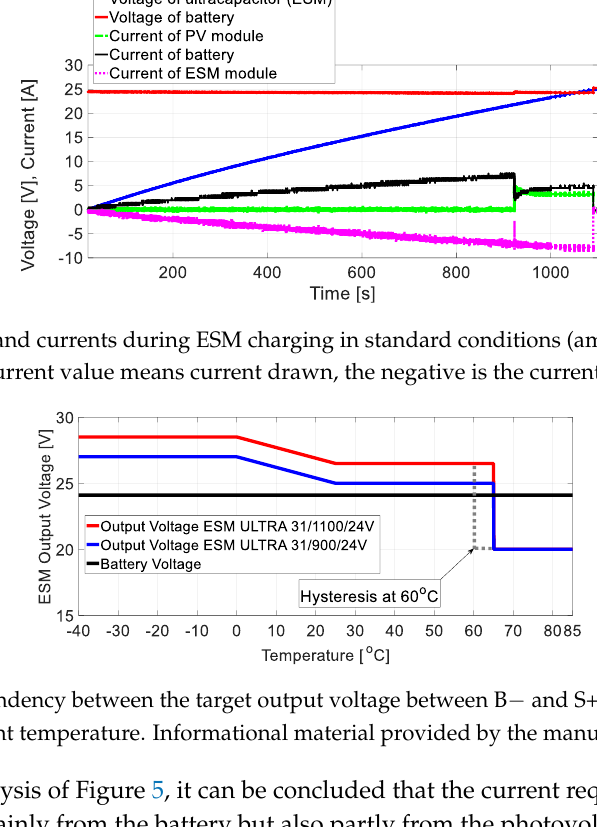
Figure 7. Voltages and currents during load: ( a ) fully charged ESM module; ( b ) partially discharged ESM, in standard conditions (ambient temperature 293 K). 5. Conclusions The experiments have shown that the ultracapacitor start-up module ESM ULTRA 31/900/24V can be extensively loaded with high current values for several-second intervals, similar to conditions during start-up cranking of high-displacement internal combustion engines. The extensive load can be applied almost to complete discharge of the ESM module (practically to the voltage of 0 V). High voltage changes help to estimate the state of charge of the ultracapacitor module and prevent the risk of a sudden loss of power of the starter motor. The voltage drop of the ESM module below a certain level can be used as a trigger signal to initialize the combustion engine start-up and start of battery charging. The proposed addition of a photovoltaic panel reduces the load on the battery during ESM charging, but most importantly, it prevents the system from the self-discharge during long nonoperational periods, where it performs the “ stand-by ” function in the system. During operation, only a small amount of current (several amperes) is drawn from the battery, which greatly extends the durability, lifetime, and usable capacity of the battery. Low current draw from the battery allows the system to operate in states of significant battery discharge. Therefore, the system can provide power over a long time to the electric installation, such as the vehicle onboard electronics (from the battery, with the nonoperating combustion engine), without the risk of combustion engine start-up difficulties. A reliable start-up is ensured by the ultracapacitor ESM module. It is worth emphasizing that the ESM module can be used either for the start-up of large gas engines or cogeneration systems. The parallel connection of the battery and the ESM module increases the energy of the energy storage as well as its power density. The solution presented in this work can be implemented as a start-up solution for other types of distributed generation systems [1] as well as vehicles such as trucks, special service vehicles, military vehicles, and city buses operating in particular environmental conditions. The research presented in the paper was conducted according to assumptions of cooperation of the elements of the PV module plus battery and